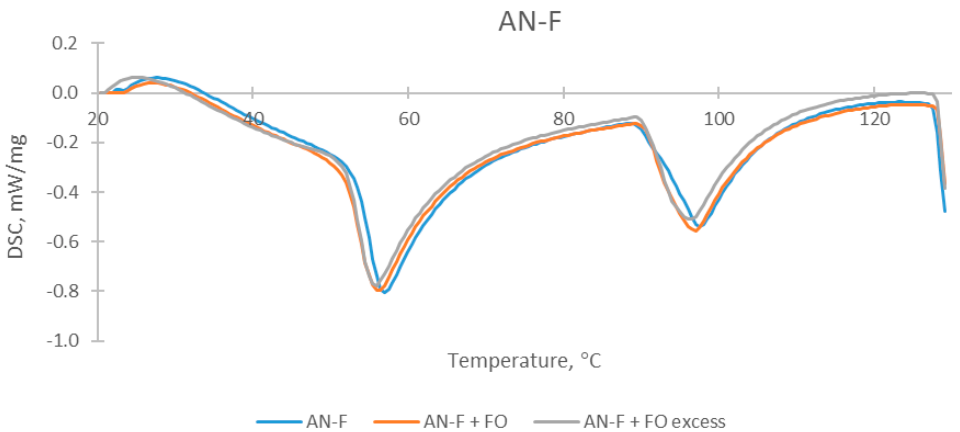
Figure 7. DSC results of AN-PP8.